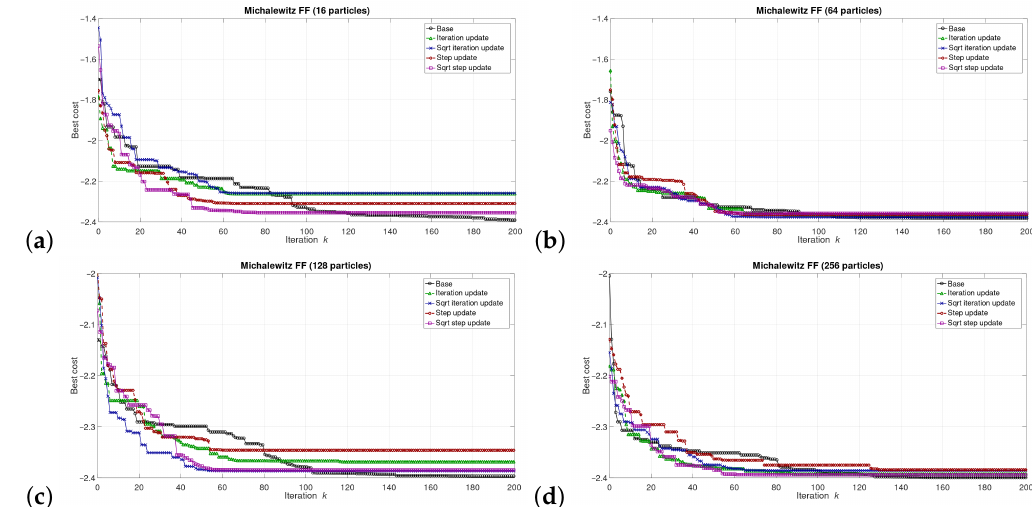
Figure 6. Selected results for Michalewitz FF for ( a ) 16, ( b ) 64, ( c ) 128, and ( d ) 256